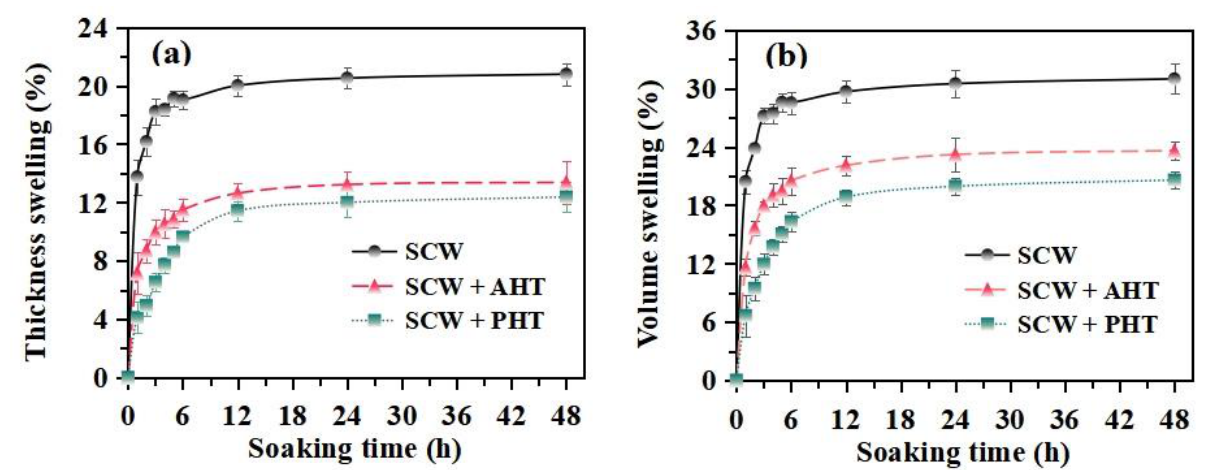
Figure 2. Water absorption-induced swelling of SCW, SCW + AHT, and SCW + PHT. ( a ) Thickness swelling and ( b ) volume swelling. SCW, surface-compressed wood without post-treatment; SCW + AHT, surface-compressed wood with atmospheric steam heat treatment; SCW + PHT, surface-com- pressed wood with pressurized steam heat treatment.